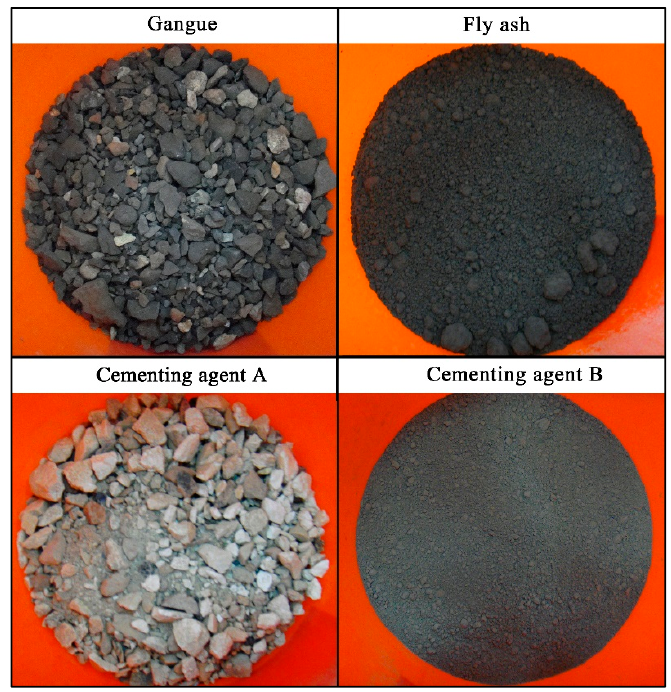
Figure 18. Components of cemented backfill material.